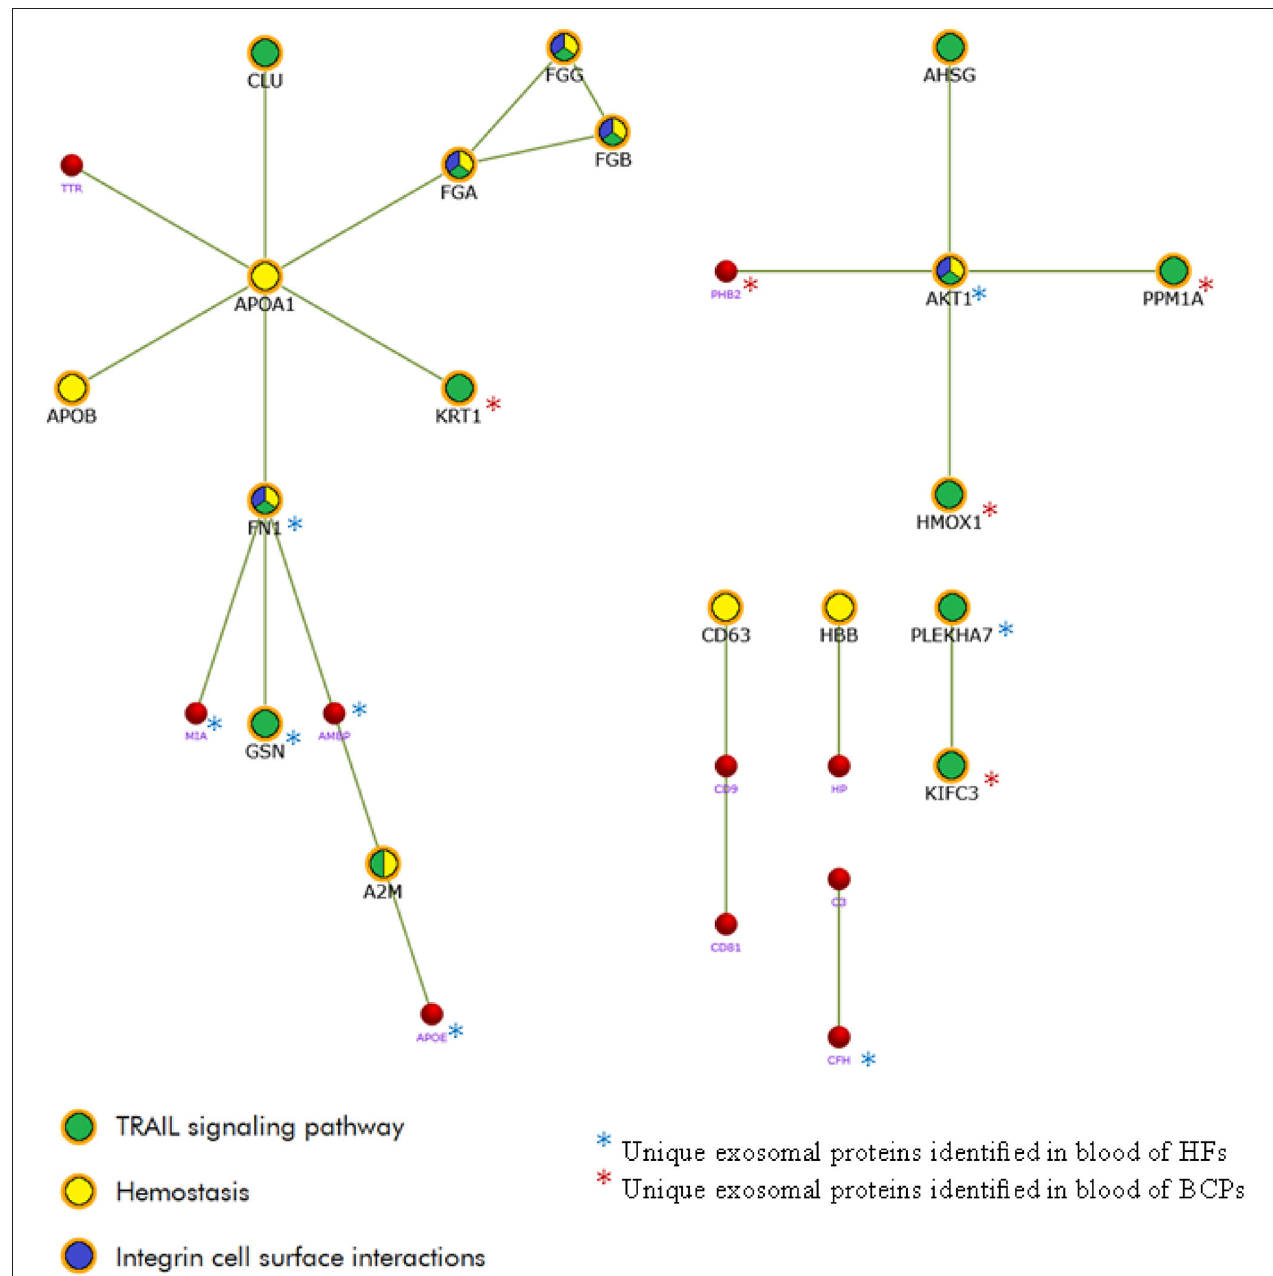
FIGURE 8 | The PPI network of the exosomal proteins involved in key stages of tumor development was constructed using FunRich 3.1.3. (http://www.funrich.org/).